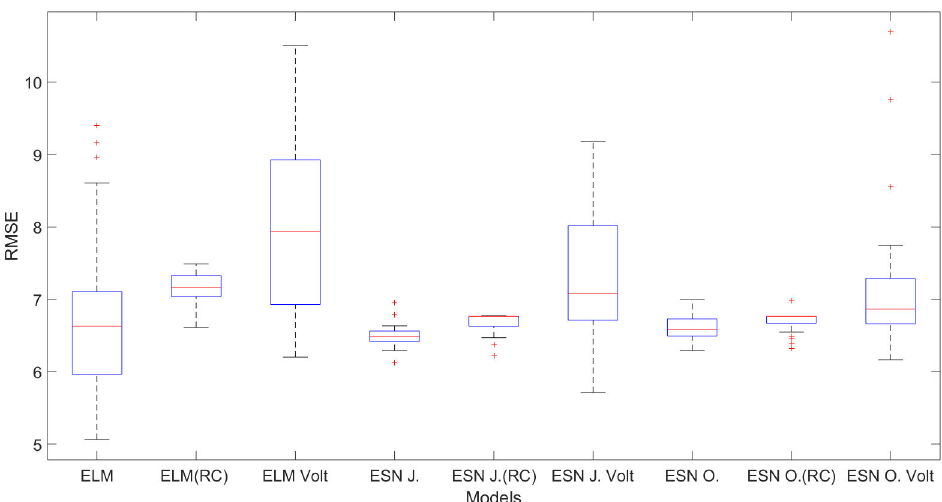
Figure 5. Boxplot graphic regarding the RMSE values for Campinas-Lag